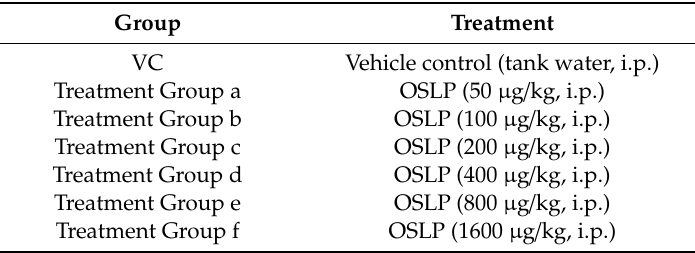
Table 1. Experimental groups in OSLP safety study.